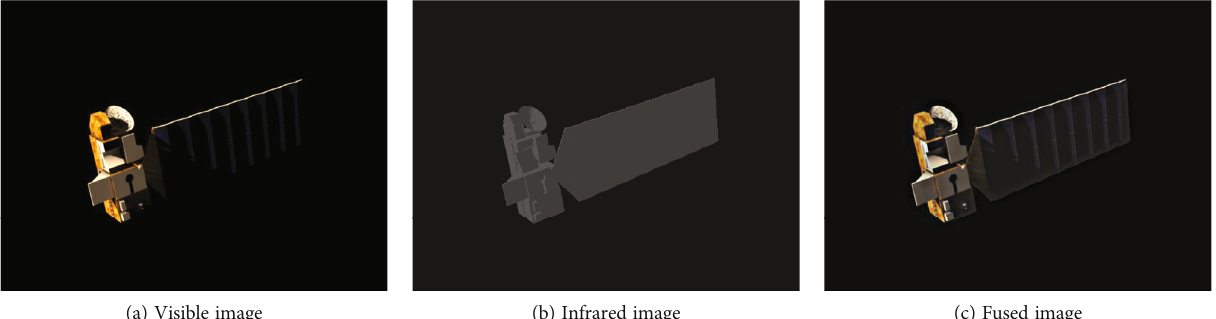
Figure 1: Illustration for infrared and visible space debris image